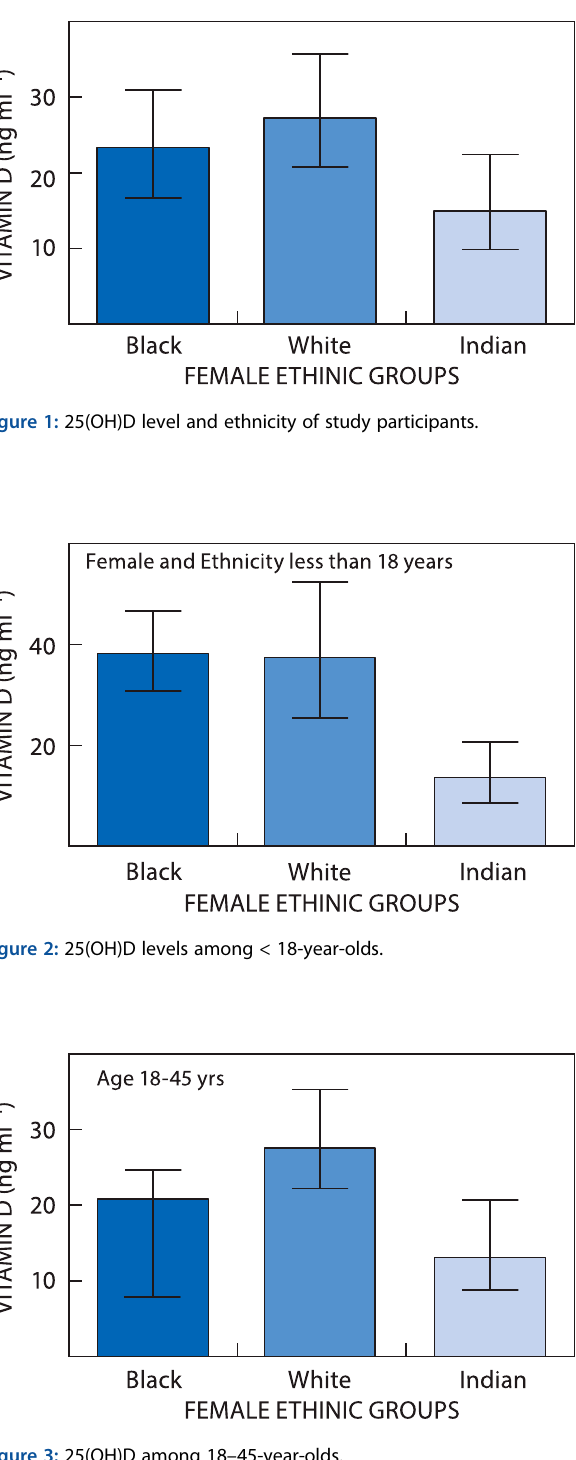
Figure 4 represents 25(OH)D levels among females who were older than 45 years old categorised according to ethnicity. The 25(OH)D median was Black (22.73 ng/ml), White (25.46 ng/ml) and Indian (17.04 ng/ml) (Tables 2 and 3) females. 25(OH)D levels 25(OH)D levels varied within the racial groups (Figure 1). The White group had significantly higher 25(OH)D levels compared with the Black and Indian groups (27.33 ng/ml; 23.43 and 15.05 ng/ml respectively; p < 0.0001). Histograms depicting 25 (OH)D level in each population group by age are outlined in